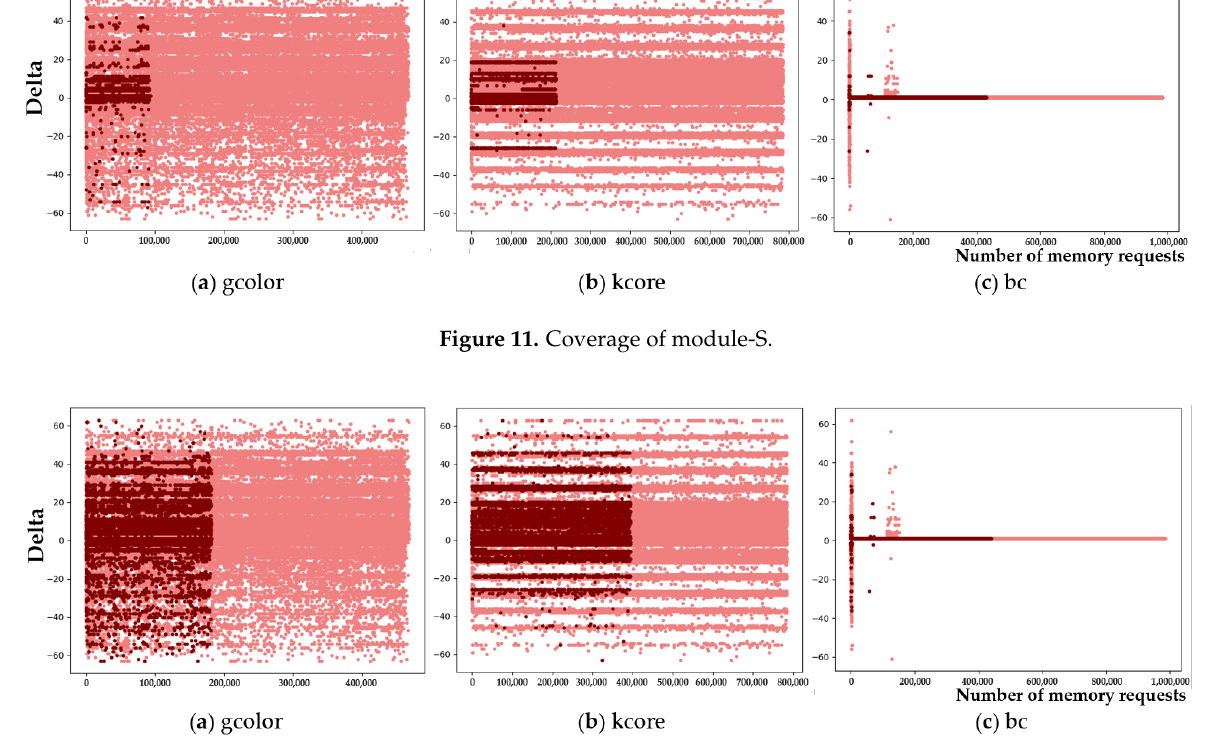
Figure 12. Coverage of propose model.